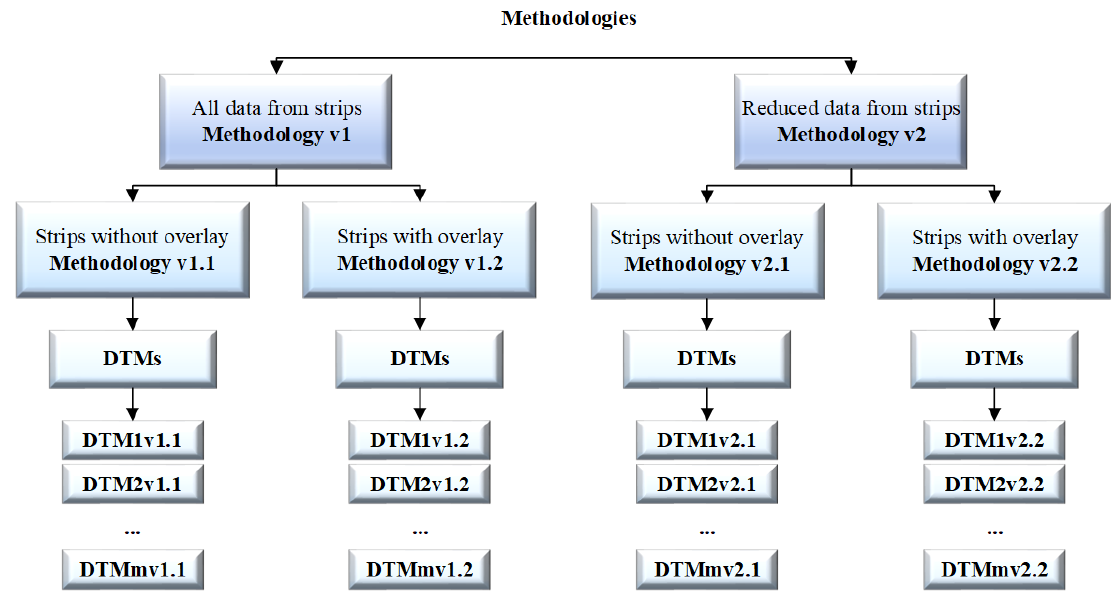
Figure 2. Scheme of the